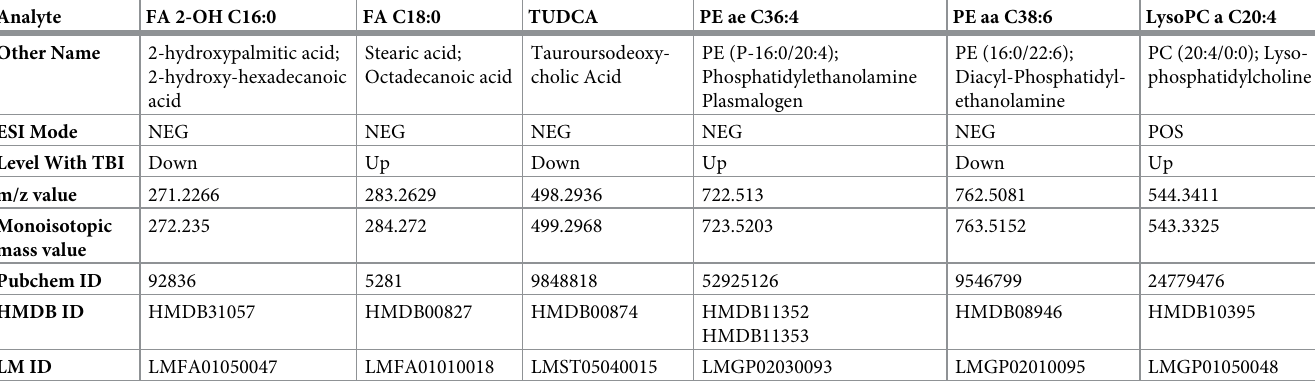
Table 5. Final MS/MS-confirmed biomarker panel analyte